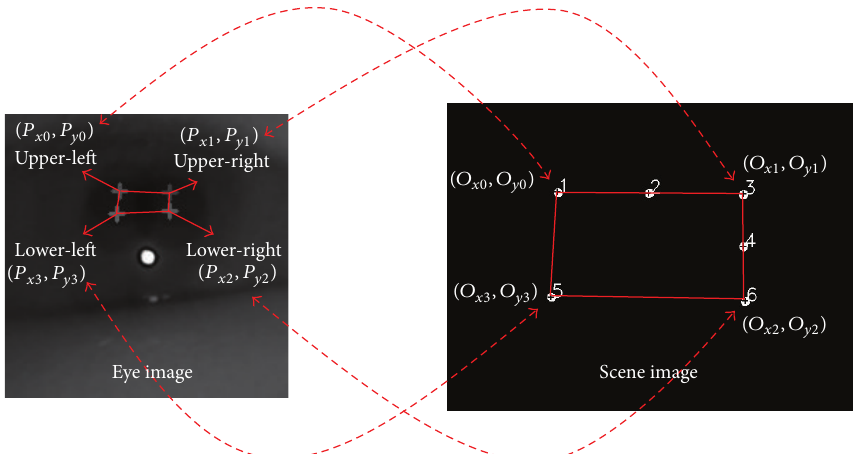
Figure 12: Mapping relationship between the pupil movable region (the rectangle given by (𝑃 𝑥0 , 𝑃 𝑦0 ) , (𝑃 𝑥1 , 𝑃 𝑦1 ) , (𝑃 𝑥2 , 𝑃 𝑦2 ) , and (𝑃 𝑥3 ,𝑃 𝑦3 ) ) on the eye image and the recognized region of the home appliance (the rectangle given by (𝑂 𝑥0 , 𝑂 𝑦0 ) , (𝑂 𝑥1 , 𝑂 𝑦1 ) , (𝑂 𝑥2 , 𝑂 𝑦2 ) , and (𝑂 𝑥3 , 𝑂 𝑦3 ) ) on the scene